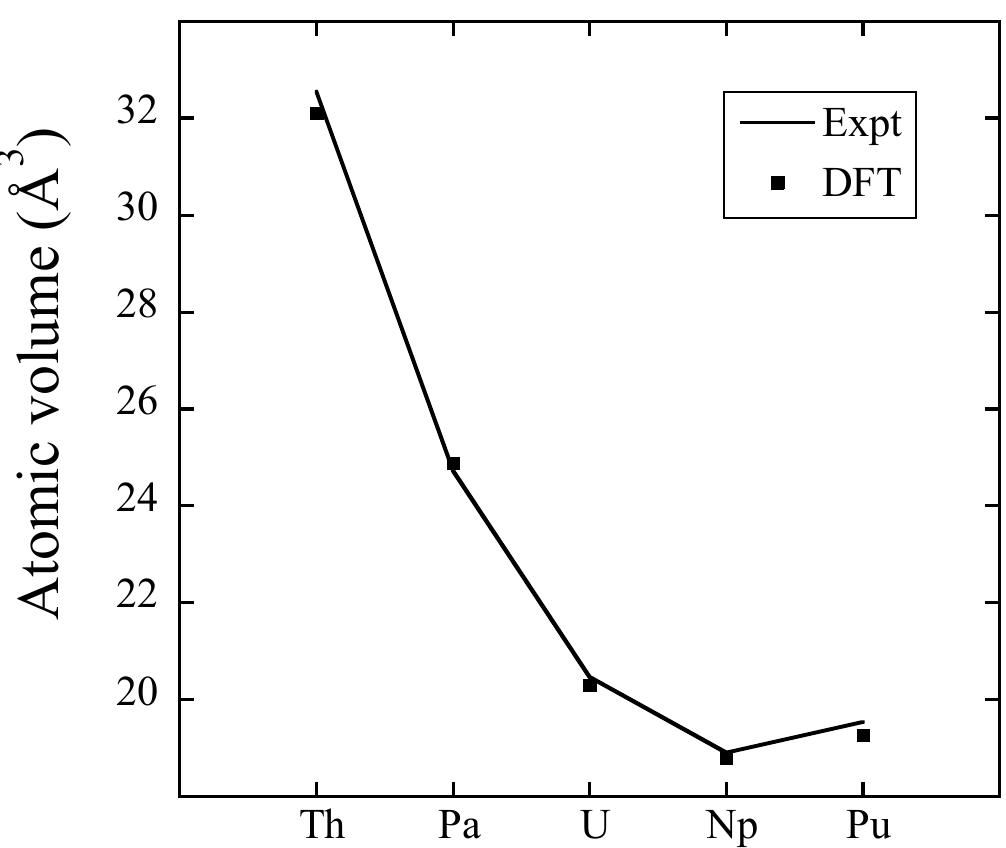
Figure 2. Experimental ( T = 0, see main text) and DFT (VASP) atomic volumes (Å 3 ). The calculations include spin–orbit coupling (not on p states) and for Pu also orbital polarization.